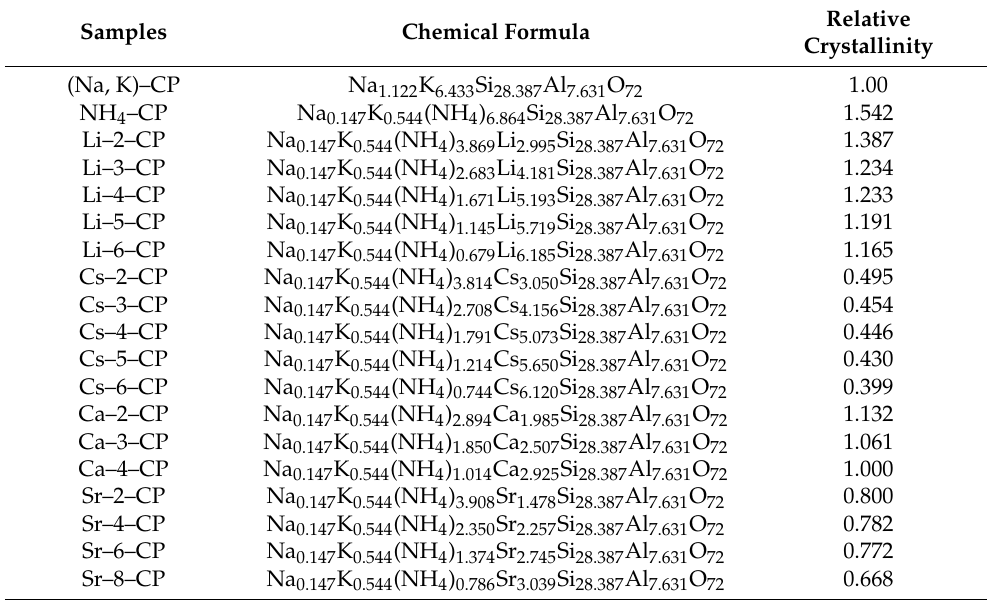
Table 1. Collections of chemical structure formula and relative crystallinity of various